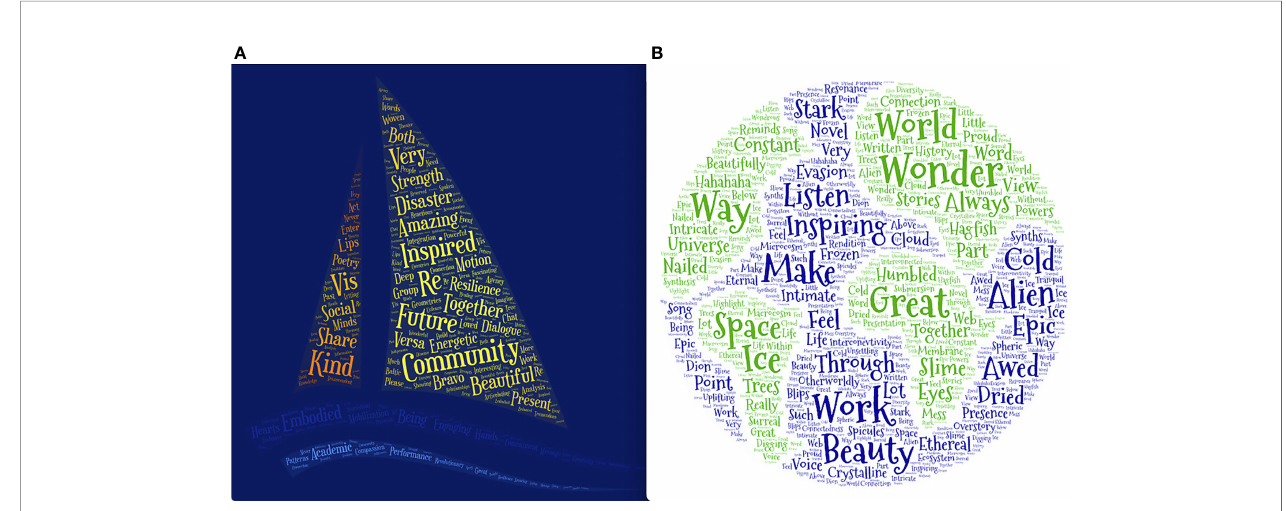
FIGURE 9 | Audience responses to the artistic works of Dennis Gupa (A) and Jol Thoms (B)